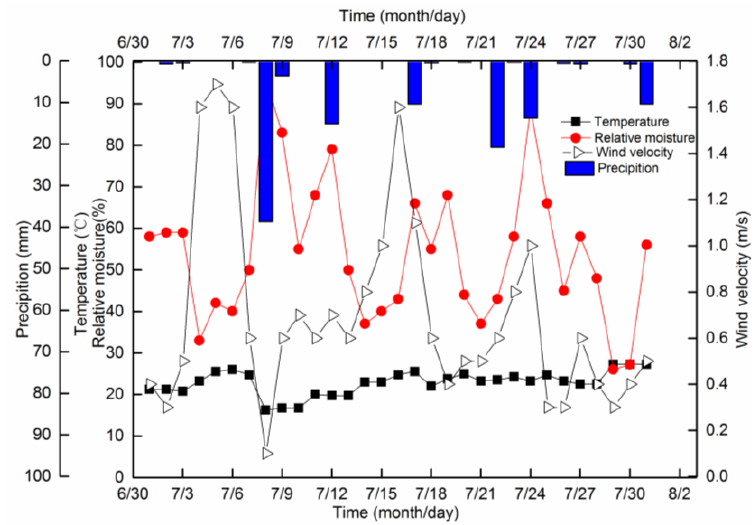
Figure 1. Test value of daily average.